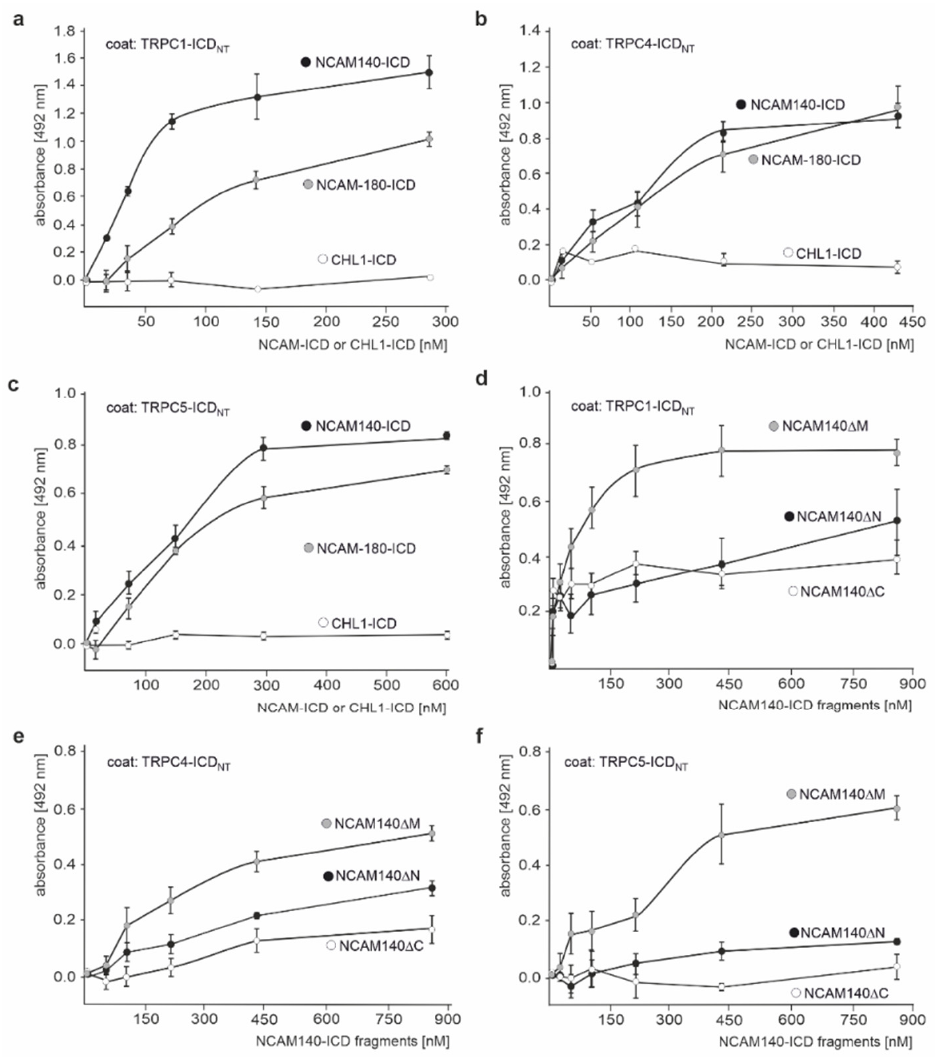
Figure 2. NCAM140-ICD and NCAM180-ICD directly bind to the N-terminal ICDs of TRPC1, − 4, and − 5. Recombinant N-terminal ICDs of TRPC1 (TRPC1-ICD NT ) ( a , d ), TRPC4 (TRPC4-ICD NT ) ( b , e ), and TRPC5 (TRPC5-ICD NT ) ( c , f ) were substrate-coated and incubated with increasing concentrations of recombinant NCAM140-ICD ( a – c ), NCAM180-ICD ( a – c ), CHL1-ICD ( a – c ), or NCAM140-ICD with a deletion of the N-terminal (NCAM140 ∆ N), middle (NCAM140 ∆ M), or C-terminal (NCAM140 ∆ C) parts ( d – f ). Binding was determined by ELISA using NCAM antibody P61 ( a – c ), CHL1 antibody ( a – c ), and NCAM antibody GTX133217 ( d – f ). Mean values ± SEM from 3 independent experiments carried out in triplicates are shown.